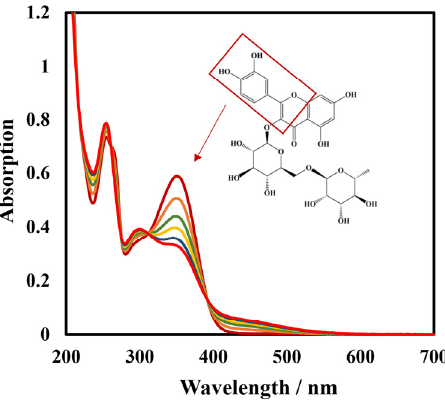
Figure 10. UV-vis spectrogram of continuous scanning Lac and rutin reaction system in 50 mmol L − 1 pH 4 phosphate-buffered solution from 200 nm to 700 nm.